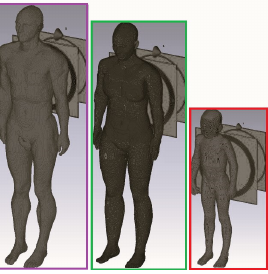
Figure 18. Tx part of a resonant WPT system in proximity to Duke, Ella, and Thelonious virtual family body